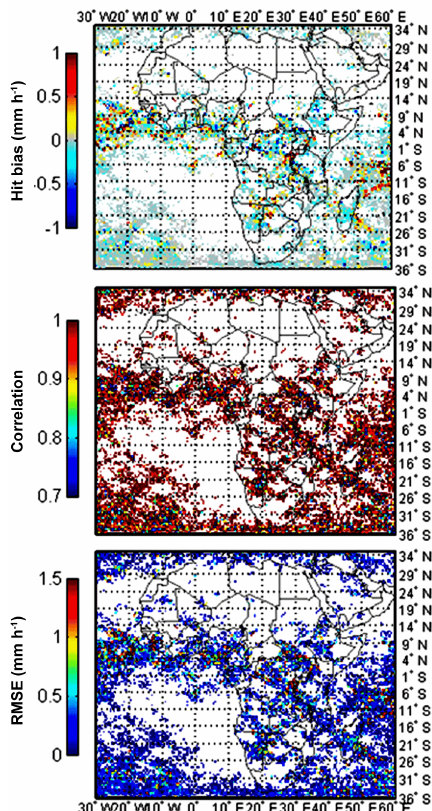
Figure 4. Hit bias (top panel), correlation coefficient (CC, middle panel), and root mean squared error (RMSE, bottom panel) resulting from the comparison between PNPR v2 and TRMM-PR retrievals over the African area (using a 0.5 ◦ × 0.5 ◦ regular grid, for the pe- riod 2013–2014).